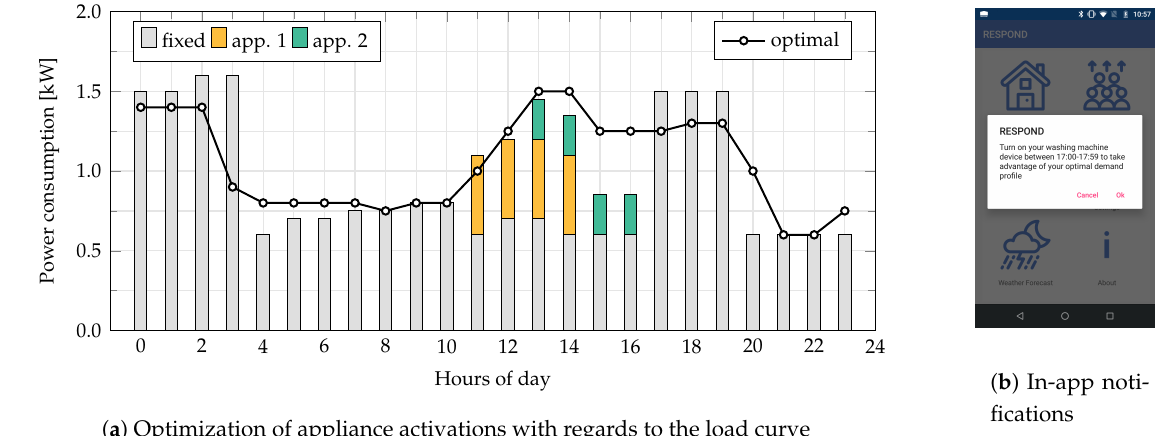
Figure 7. An example of the optimization process for appliance activations and resulting notification